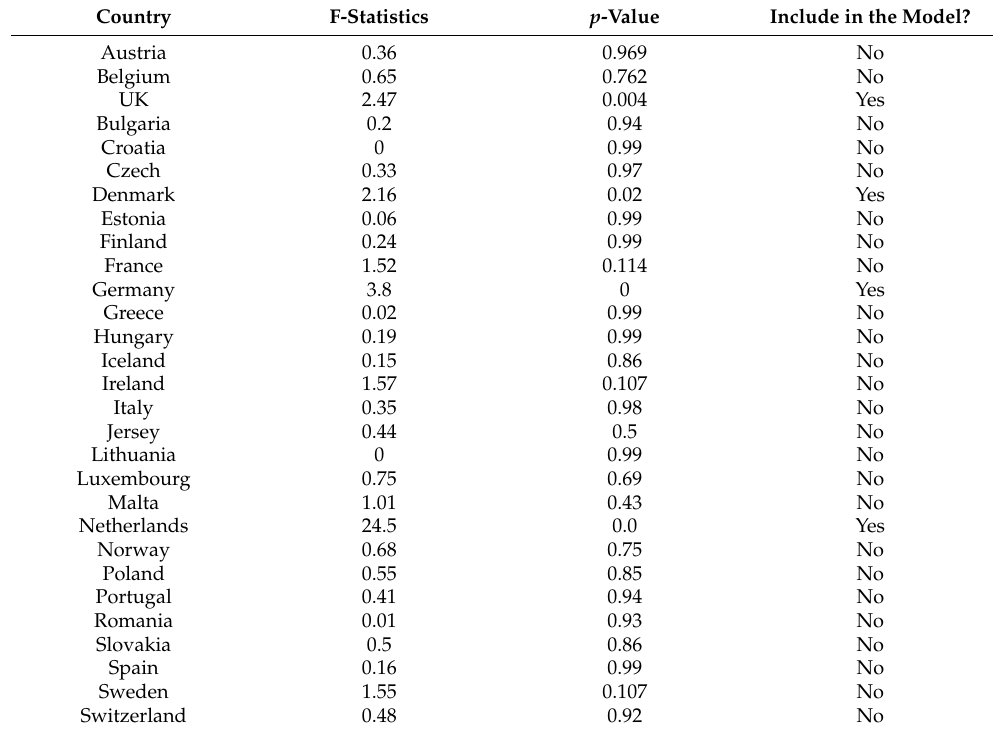
Table A3. Estimation of Chow